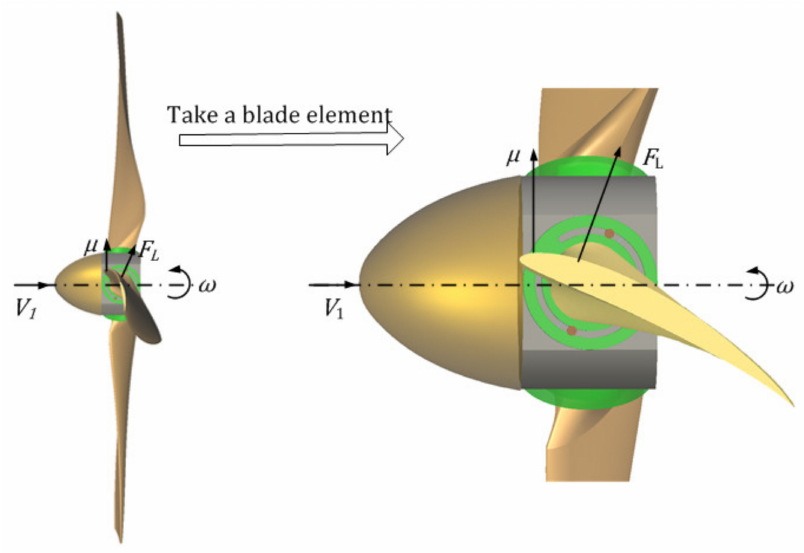
Figure 1. Schematic diagram of the driving force of the lift-type turbine.